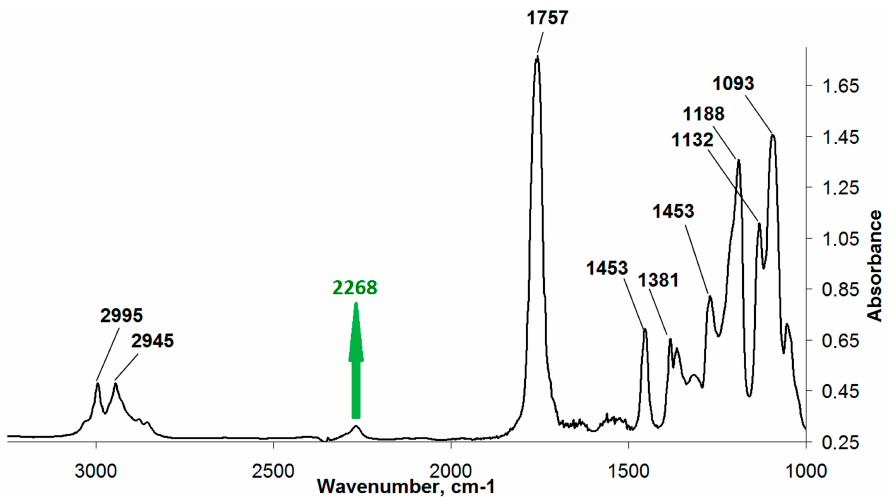
Figure 4. IR spectrum of the reaction mixture obtained at the first stage, after its purification by reprecipitation.